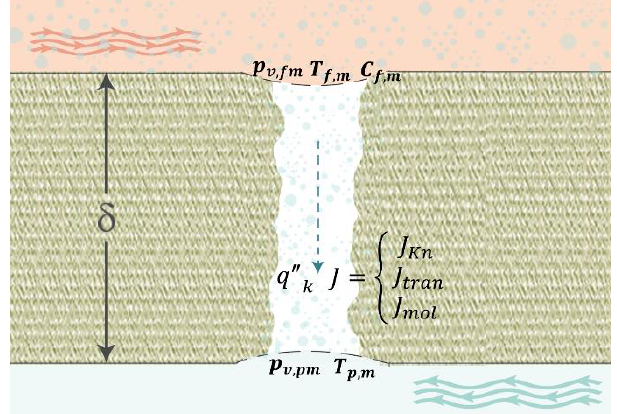
Figure 1. Sketch (not to scale) illustrating mass transfer and conduction heat transfer through a MD membrane. Temperature and water vapour pressure differences are the driving forces across the hydrophobic membrane leading to water vapour and heat transfers.